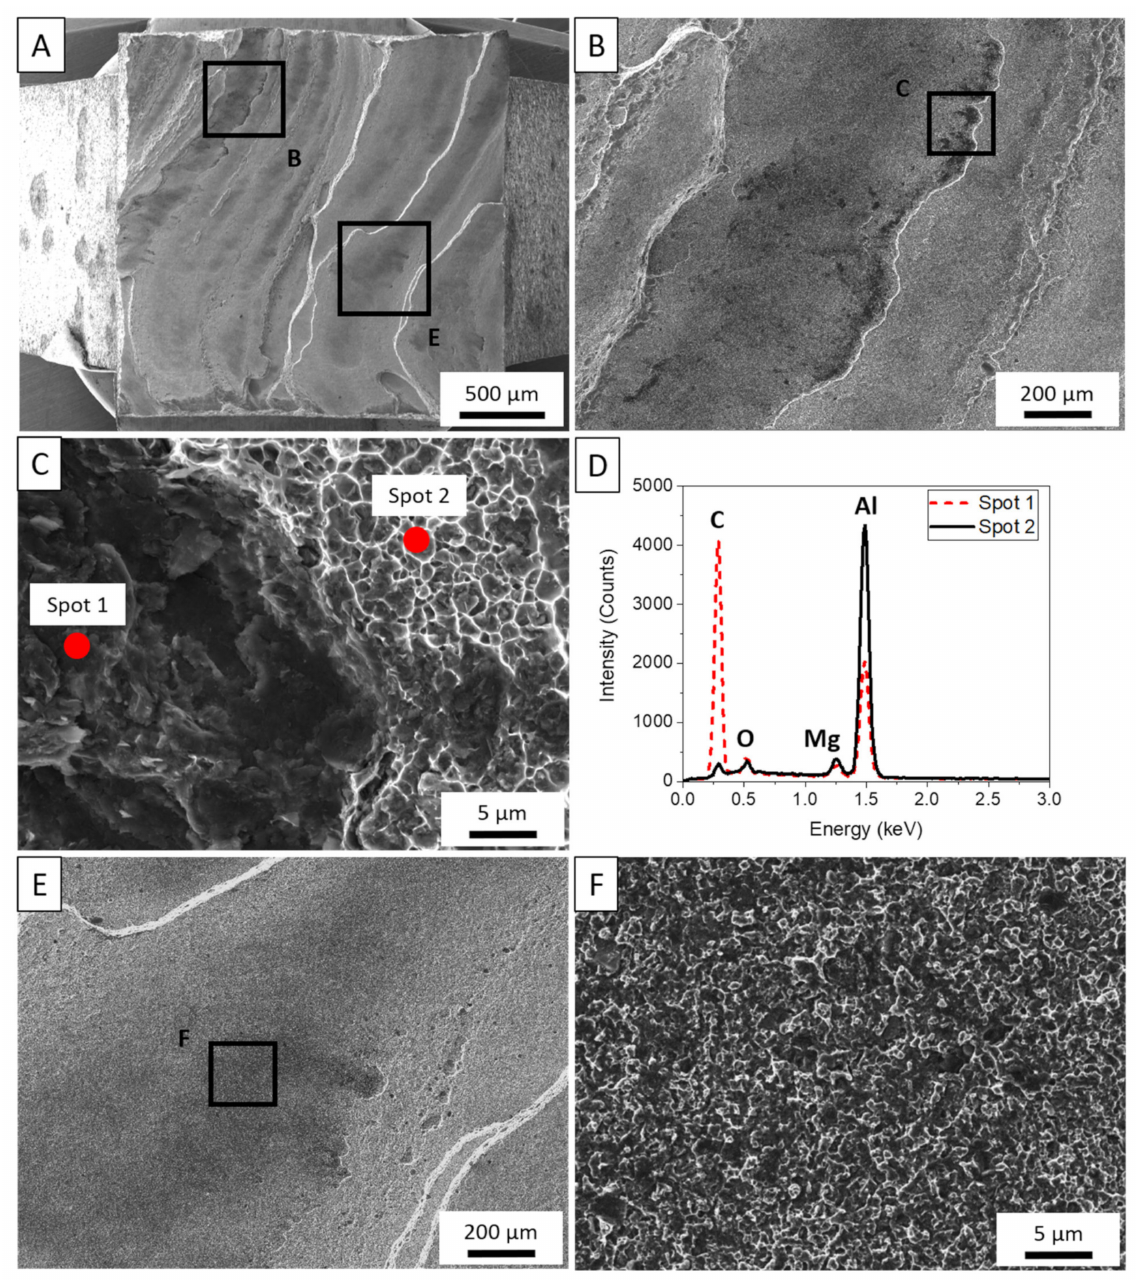
Figure 9A–F collates fractographic and EDS analysis of a sample tested in the build direction. The BD samples reveal a flat fracture surface, characteristic of a brittle failure, with tearing ridges separating thin layers of material. Near some ridges, the dark particles are observed in greater quantities such as those seen in Figure 9B. Two regions were probed to determine the composition of the contaminants in Figure 9C,D. As previously observed in the fractographic analysis of the LD samples, these dark regions are confirmed to be carbon contamination from the lubrication. Figure 9E,F show that even away from the ridges, the carbon particles sit within shallow dimples throughout the surface of the build direction samples.